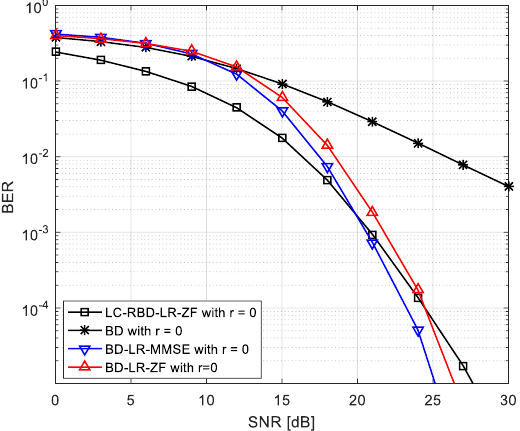
Fig. 5. The system performance